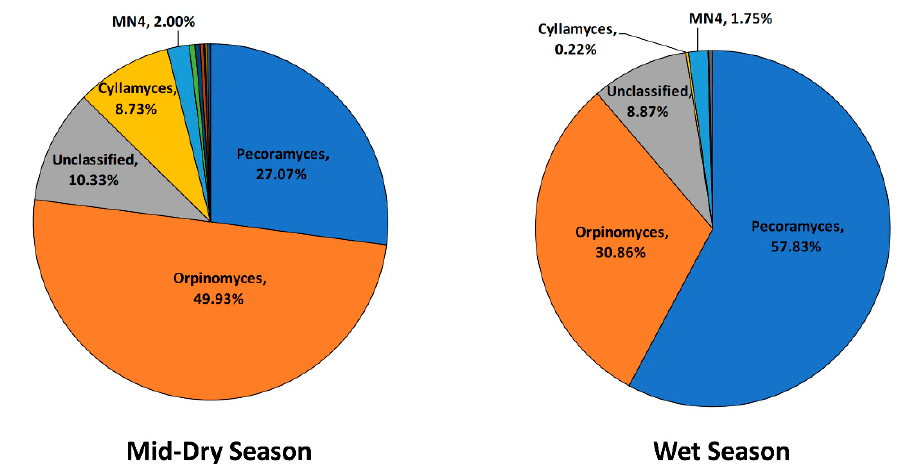
Figure 5. Taxonomic composition of the rumen fungi community at the genus level for the mid-dry and wet seasons in un-supplemented animals.